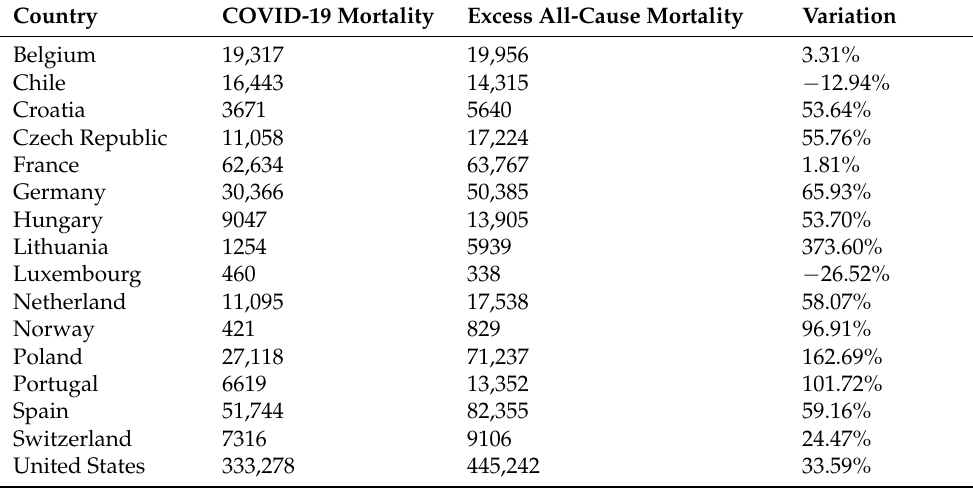
Figure 3. The excess and COVID-19 mortalities during the 10th–52nd weeks in 2020 in 16 countries. Excess mortality is calculated based on the benchmark estimated by the SARIMA model. Table 1. COVID-19 and excess all-cause mortality during the 10th–52nd weeks in